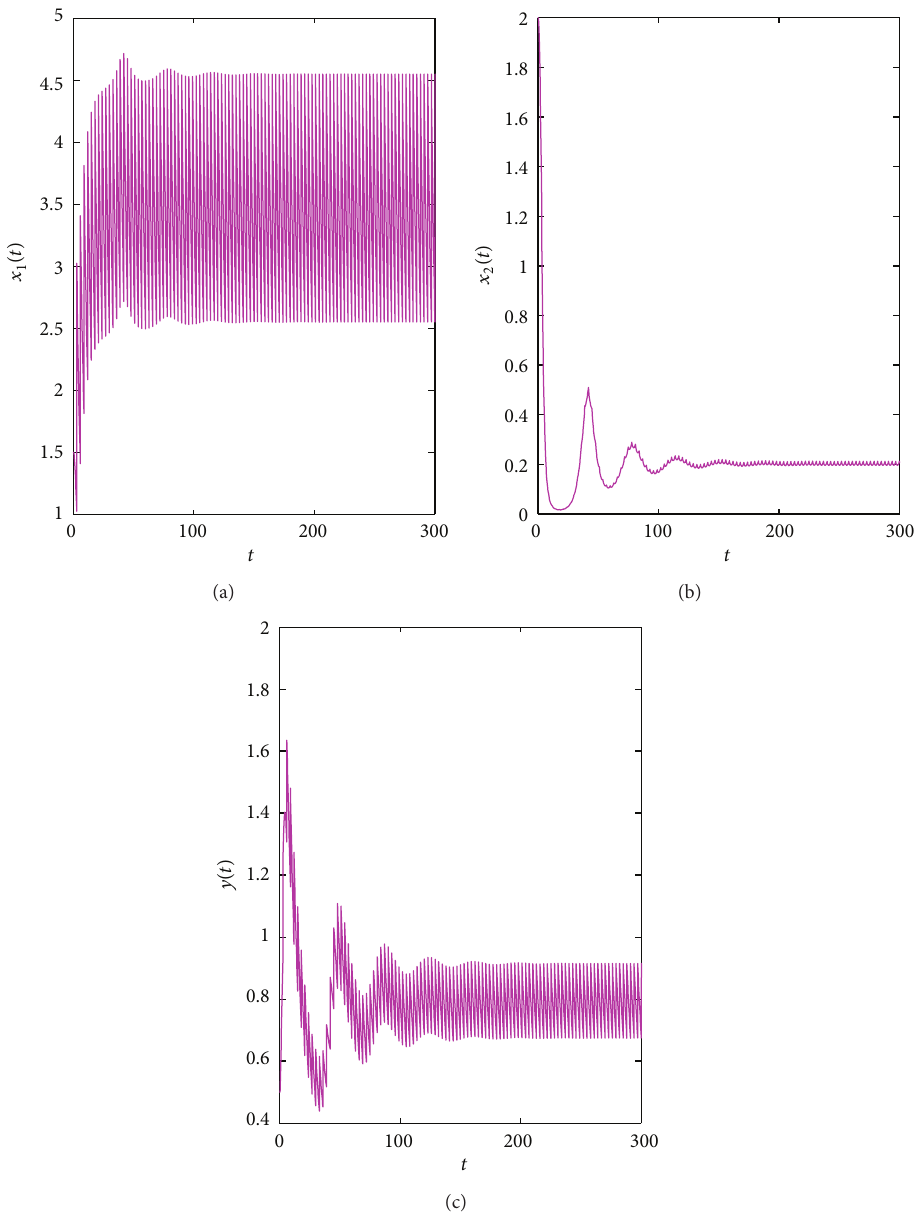
Figure 2: Dynamical behavior of system (1); the parameter values are as follows: 𝑟 = 1.2, 𝜏 = 0.5, 𝜔 = 0.2, 𝛽 = 1.2, 𝑘 = 0.2, 𝑑 1 = 0.1, 𝑑 2 = = 0.15, 𝑝 = 0.1, 𝑝 = 0.7, 𝑎 = 5, 𝑏 = 6,𝜇 = 2 , and 𝑇 = 3 0.2, 𝑑 3 0